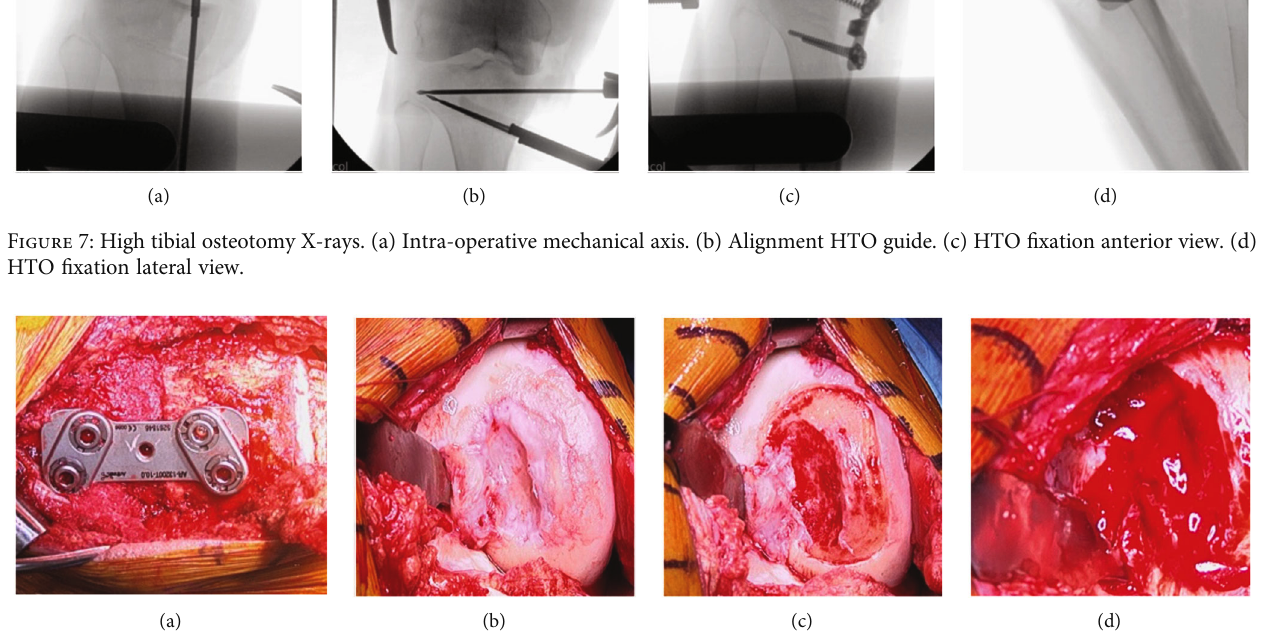
Figure 8: HTO, lesion characteristics. (a) High tibial osteotomy. (b) OCD poorly contained lesion. (c) Prepared lesion site. (d) Bleeding created base